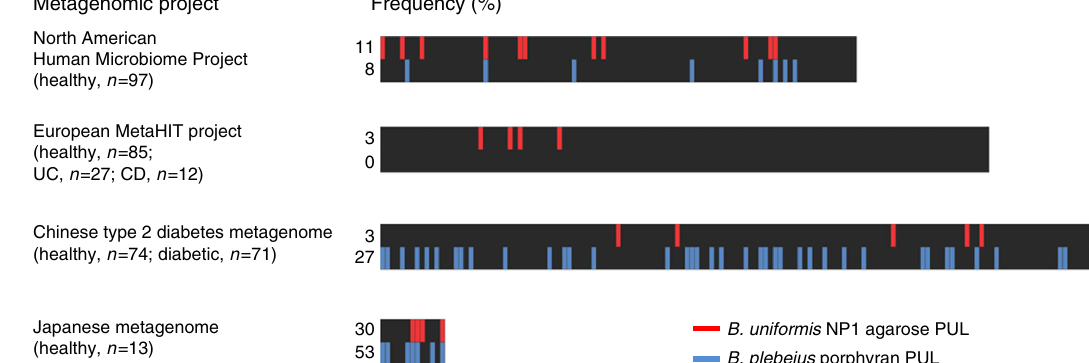
Fig. 7 Abundance of algal galactan-speci fi c PULs in human microbiomes. Four metagenomic data sets were individually queried by BLAST using the trimmed Bu Ag-PUL nucleotide sequence and the porphyran PUL sequence from Bp . Data were organized by metagenomic projects, the general information of which is listed on the left (UC ulcerative colitis, CD Crohn ’ s disease). Vertical lines representing the Bu NP1 Ag-PUL (red) and Bp porphyran PUL (blue) indicate the absence or presence of this PUL in a single individual. Black bars represent the total size of each metagenomics project, with the frequency of hits for each PUL shown to the left of each black